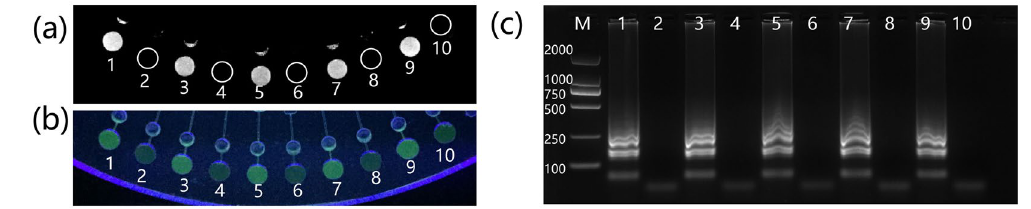
Figure 4. Cross contamination testing of the chip. ( a ) Image captured in the gel imager. Reaction chambers are numbered from 1 to 10, and the dashed lines mark the positions of reaction wells with no signals. ( b ) Photo of signals excited by UVC and taken by a camera. ( c ) Electrophoretogram of the amplicons in each reaction chamber. M represents the DNA